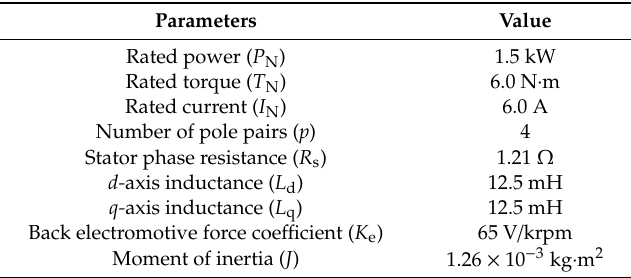
Table 6. Main parameters of the test